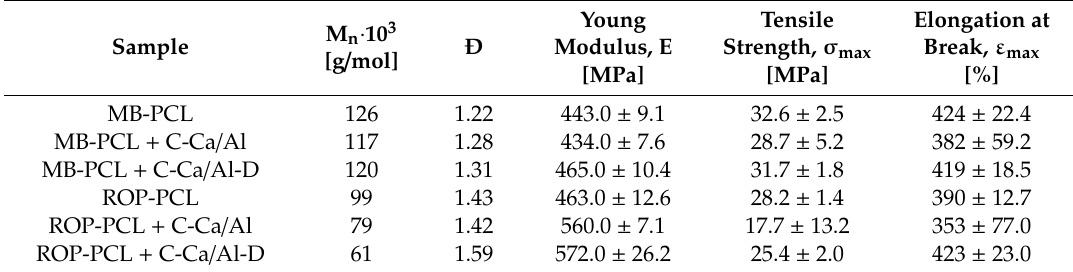
Table 3. Average molecular weight ( M n ), dispersity (Ð) and tensile properties of neat PCL and PCL